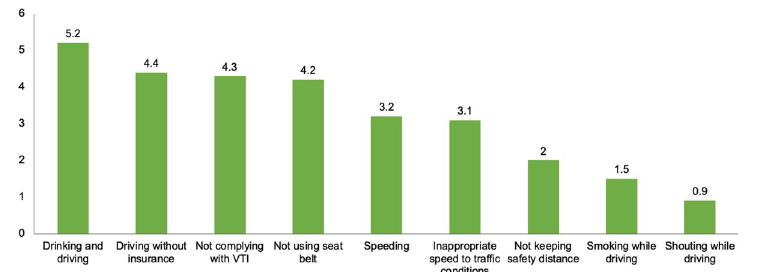
Fig 6. Perceived risk of being sanctioned for different road